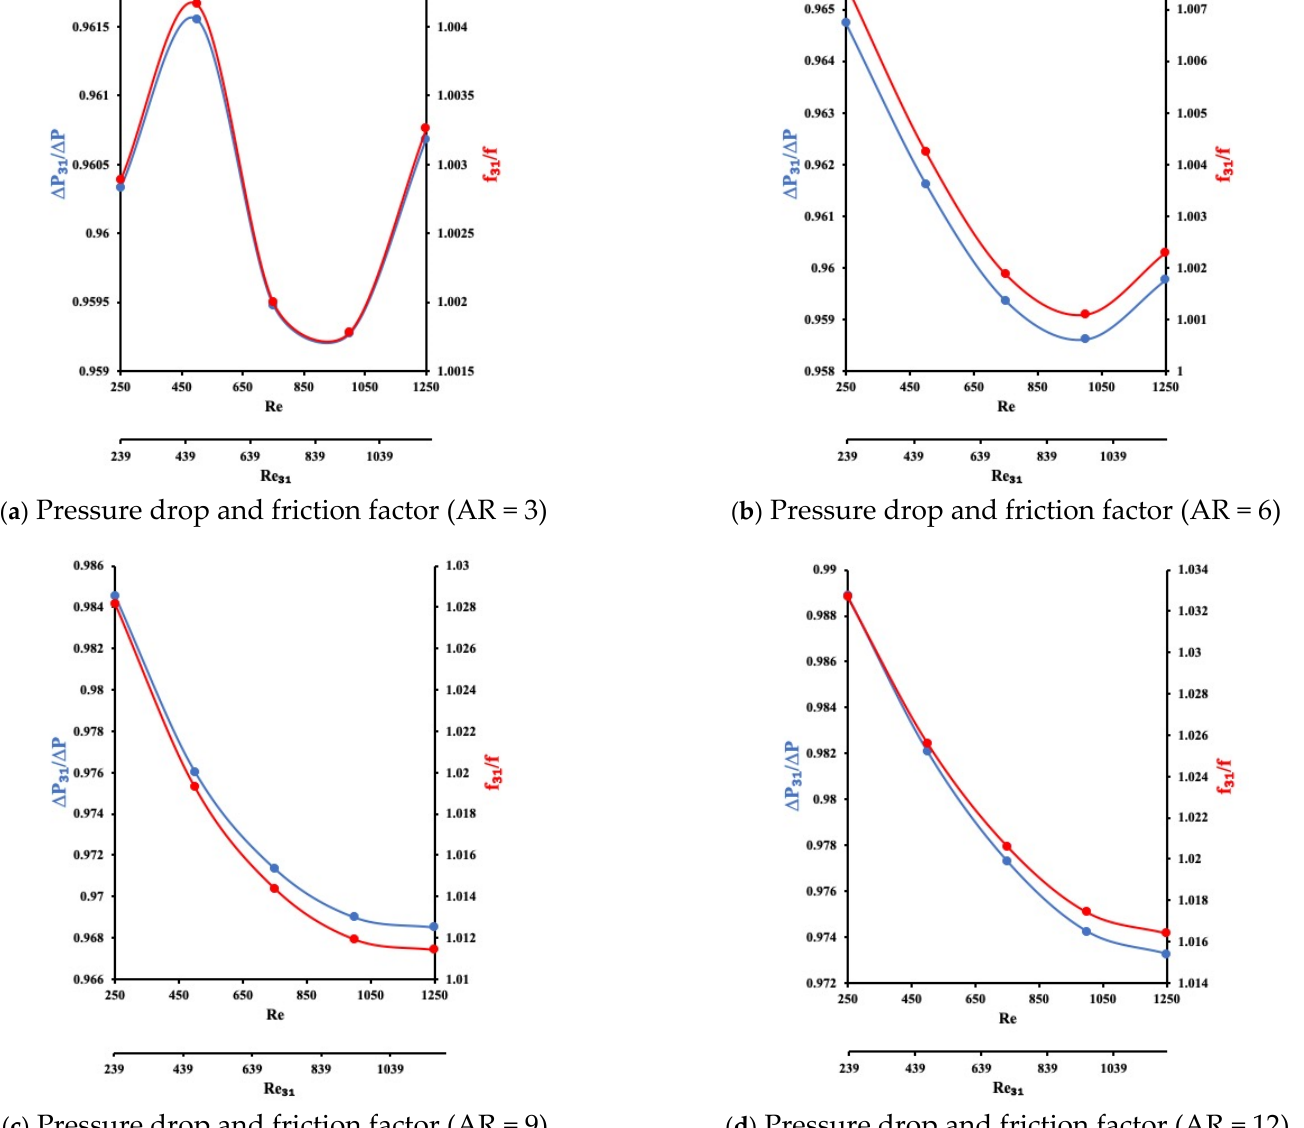
Figure 7. The ratio of the pressure drop and friction factor between nanofluid and water (dp = 31 nm).